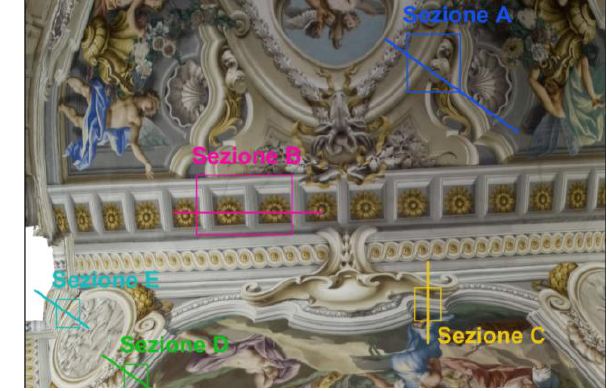
Figure 13 – Detail of a corner of the TLS model of the central vault